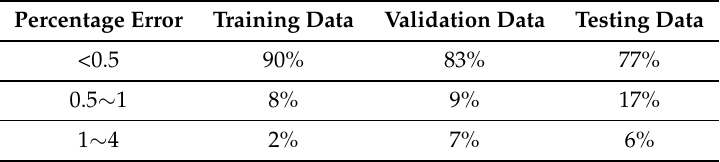
Table 5. Percentage error of predicted outputs in various datasets.